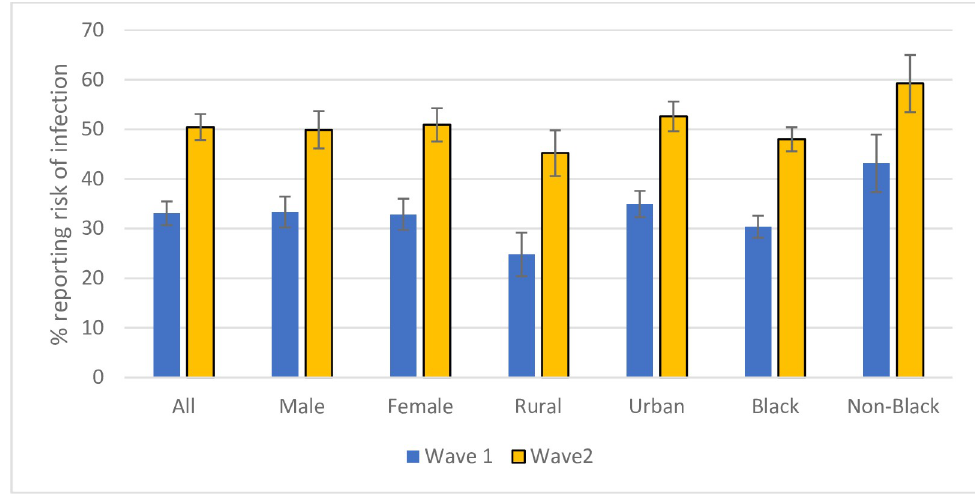
Fig 3. Covid-19 risk perception over Wave 1 and Wave 2. Source: NIDS-CRAM, Wave 1 (2020) and NIDS-CRAM, Wave 2 (2020) Data are weighted. The bars show the risk perception in percentage. 95% confidence intervals are shown.